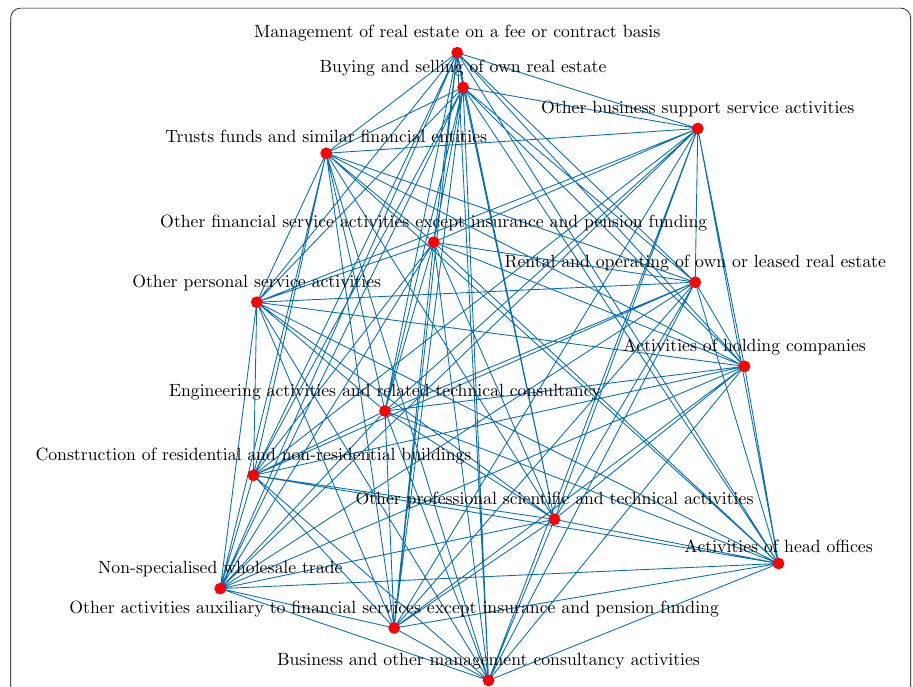
Fig. 6 Densest k-core on the meta-graph of sectors ( k = 218 , limited to 15 highest degree sectors for